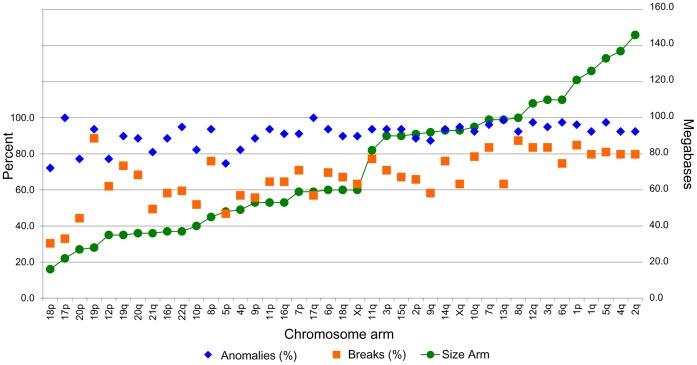
Chromosomal anomalies and breaks across the genome of TP53 mutation-positive HGSC cases.Percentage of the 79 TP53 mutation-positive HGSCs with chromosomal anomalies, including copy number alteration and allelic imbalance, and breaks occurring per chromosome arm, as inferred by reviewing image files created by the Genome Viewer module in BeadStudio Data Analysis software v2.2.22. The chromosome arms are arranged according to their size in megabases, left to right from smallest to largest.